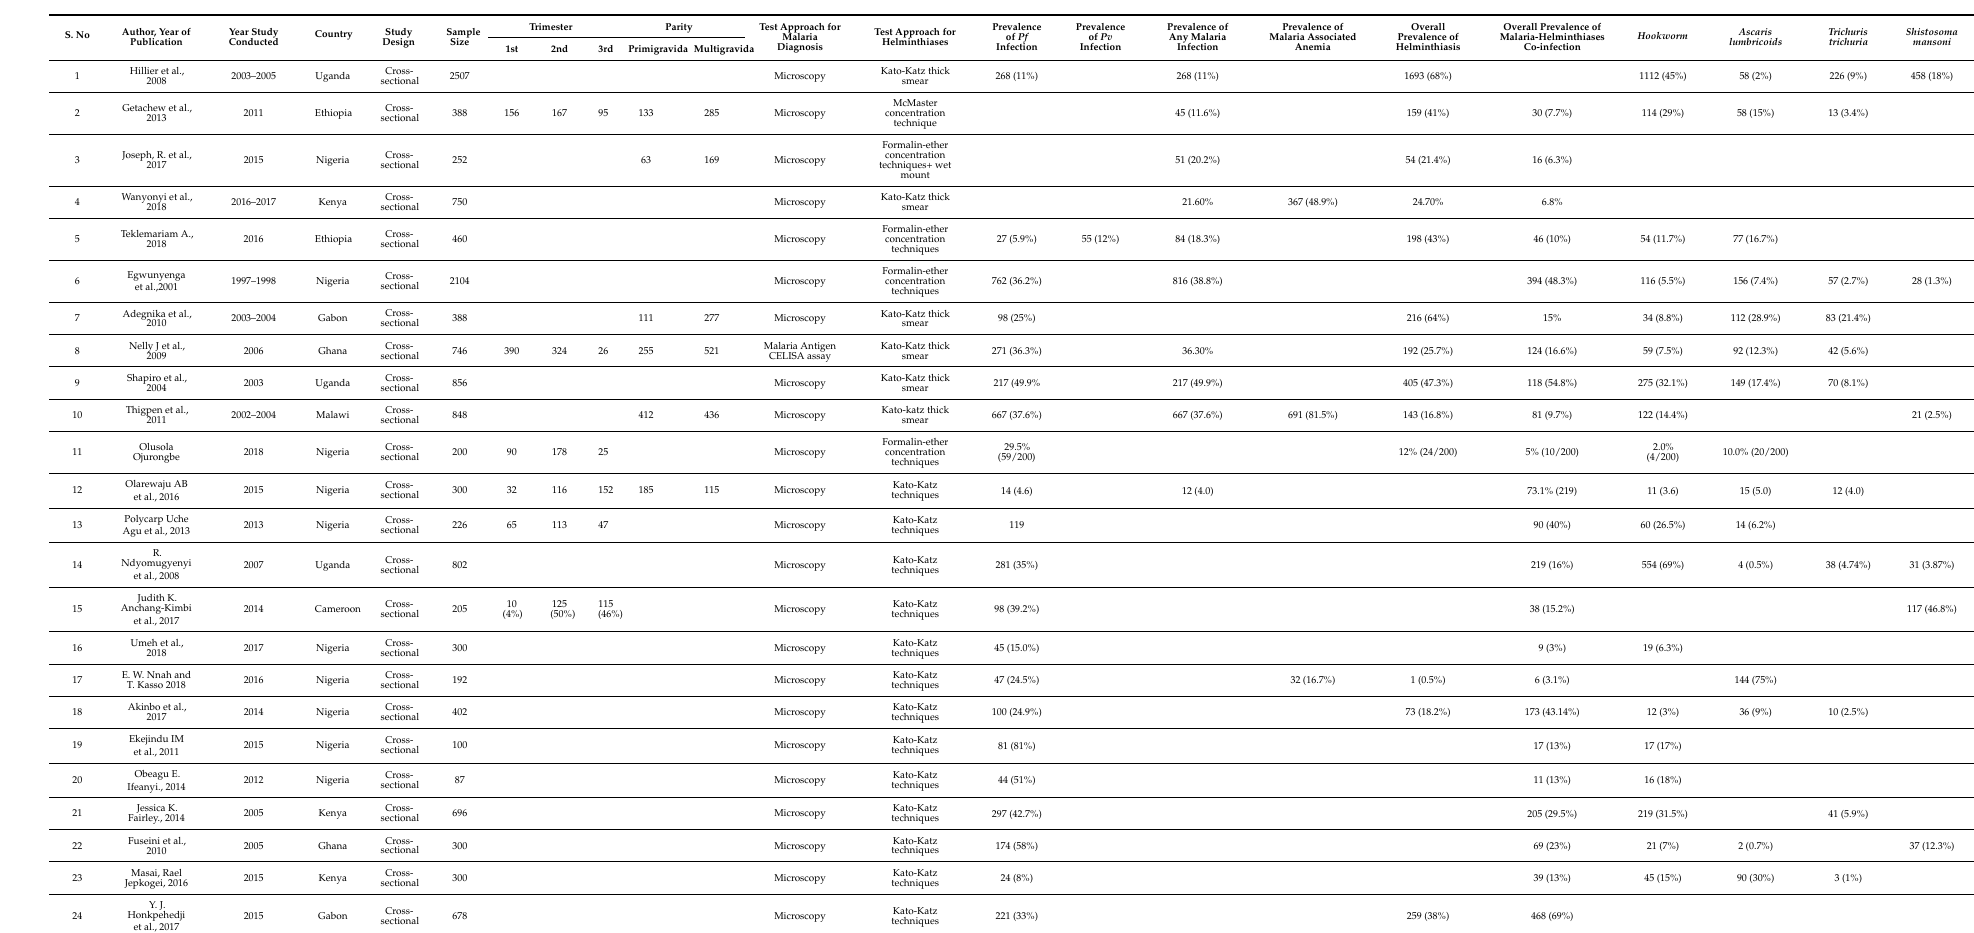
Table 2. Descriptive summary of the eligible